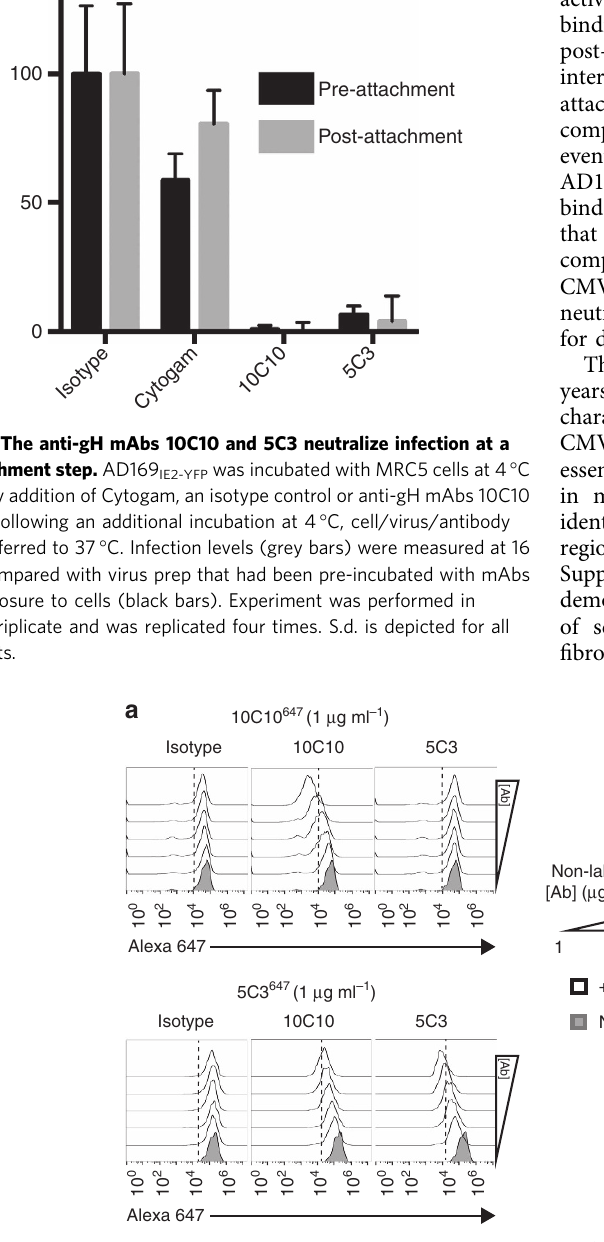
Figure 7 | mAbs 10C10 and 5C3 bind to a similar region within gH. ( a )U373 gH/gL cells were left unstained (grey peak) or were labelled with mAbs 10C10 (top row) and 5C3 (bottom row) conjugated to an Alexa647 fluorophore (10C10 647 and 5C3 647 ), together with increasing concentrations of non-conjugated 10C10 or 5C3 (1–20 m gml (cid:2) 1 ; white peaks). ( b ) The percentage of cells stained by 5C3 647 in the presence of non-labelled 10C10 (black bars) or non-labelled 5C3 (grey bars) is depicted for all concentrations. Experiment was performed in technical duplicate and was replicated four times. S.d. is depicted for all experiments. * P o 0.05 (Student’s two-tailed t